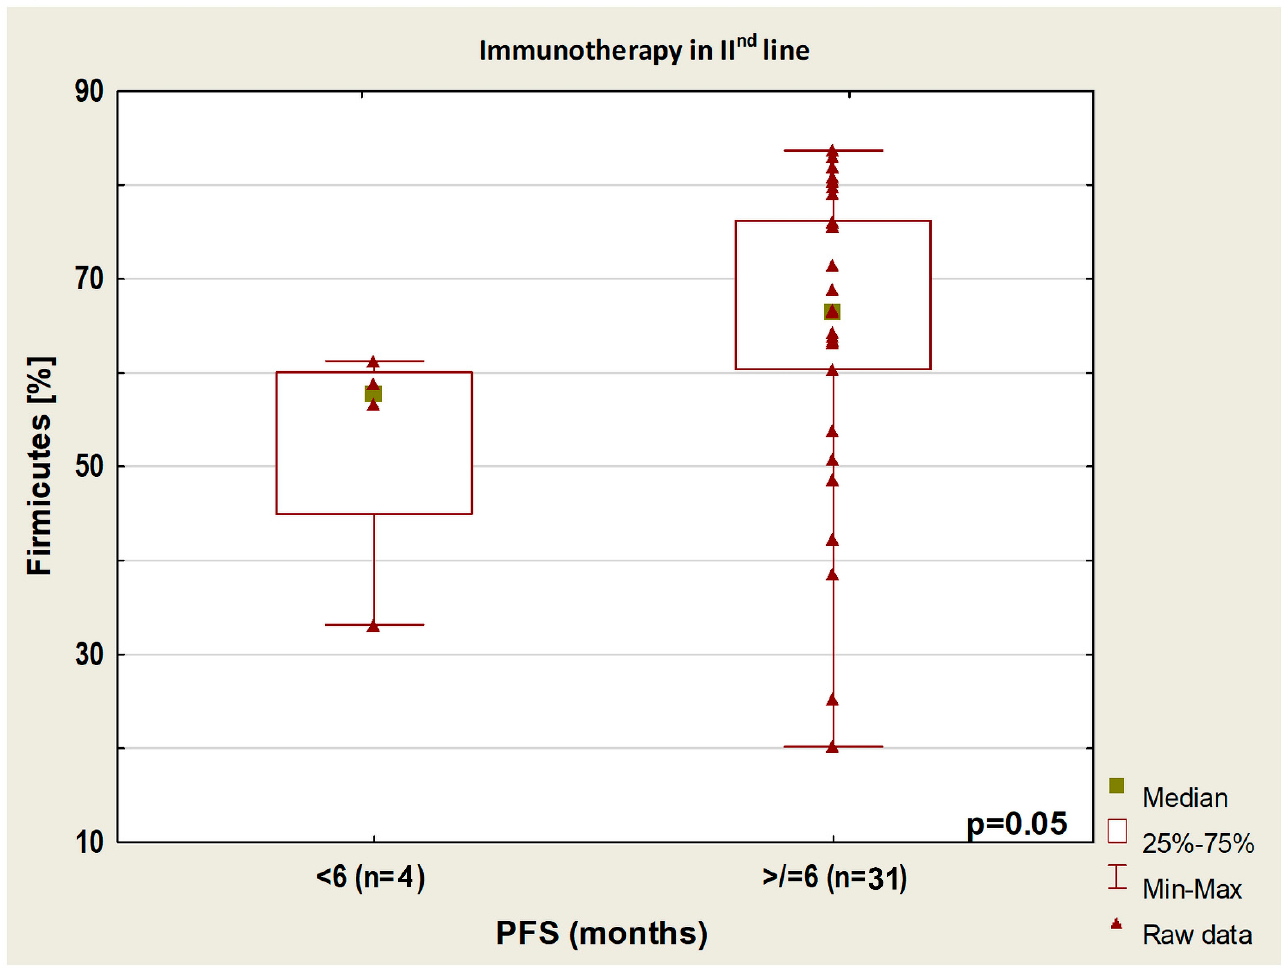
Figure 7. Boxplot showing Firmicutes content in patients with PFS above or below 6 months from the start of immunotherapy.